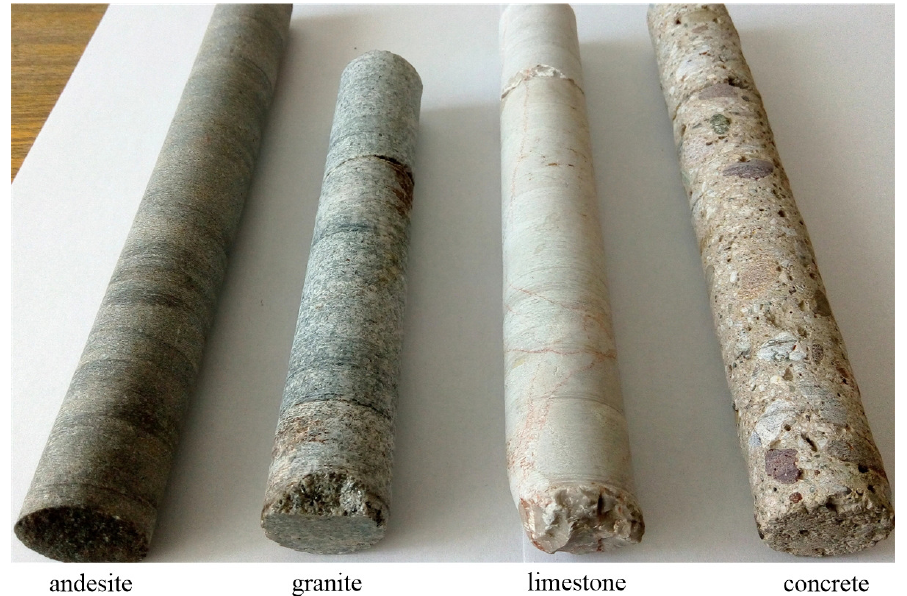
Figure 5. Drilling cores of disintegrated